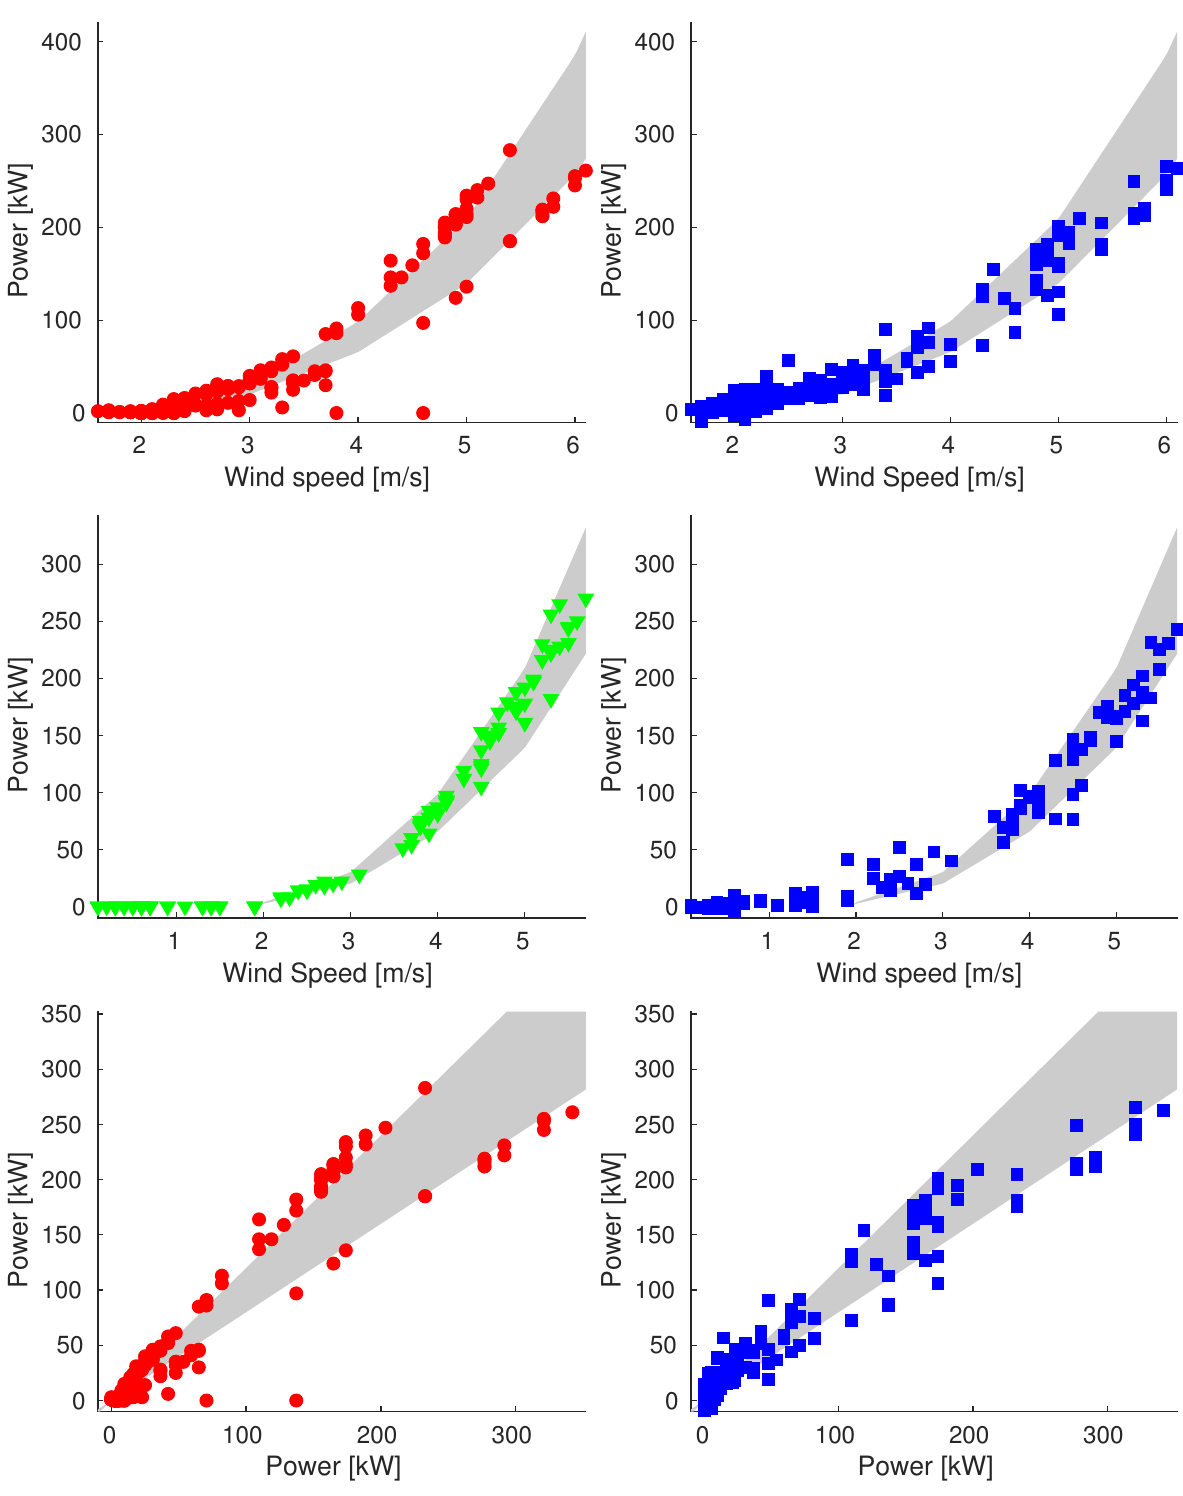
Figure A6. Plot of reconstructions for data points of 18 August ( Sample_90 ). We compare original data (on the left ) and reconstructed values (on the right ). We show plots of power vs.wind speed of rejected and validation data ( up and middle respectively) and plot of power vs.ideal power of rejected data ( bottom